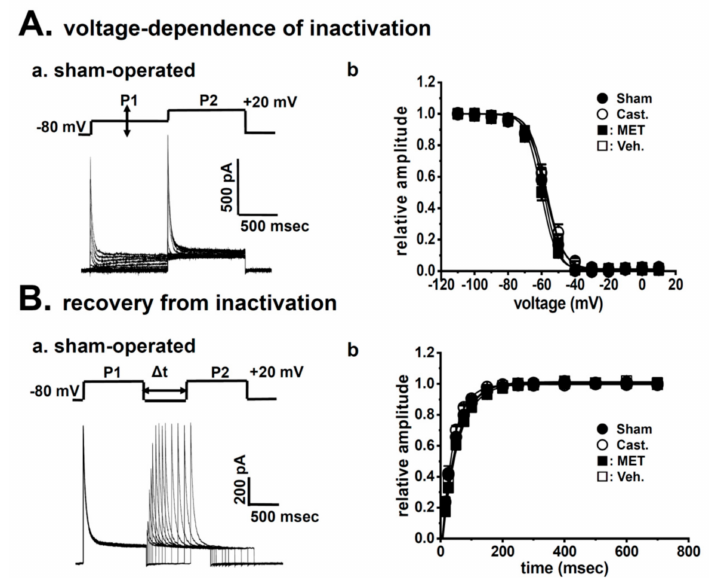
Figure 4. E ff ects of castration on I A kinetics in rat VDSMCs. ( Aa ) The steady-state voltage dependence